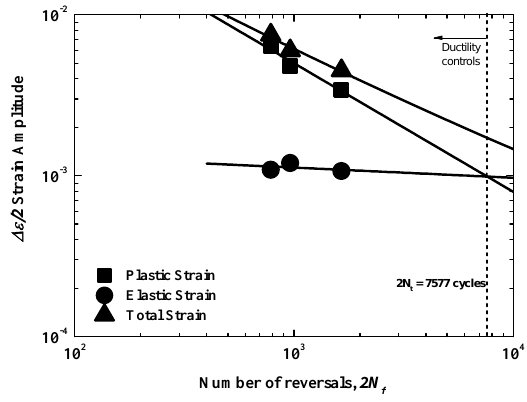
Figure 9. The Coffin–Manson curves of Alloy 617 at the 950 °C condition. Table 3. The Coffin–Manson coefficients of Alloy 617 completed at 950 °C and a strain rate of 10 − 3 /s. Parameters